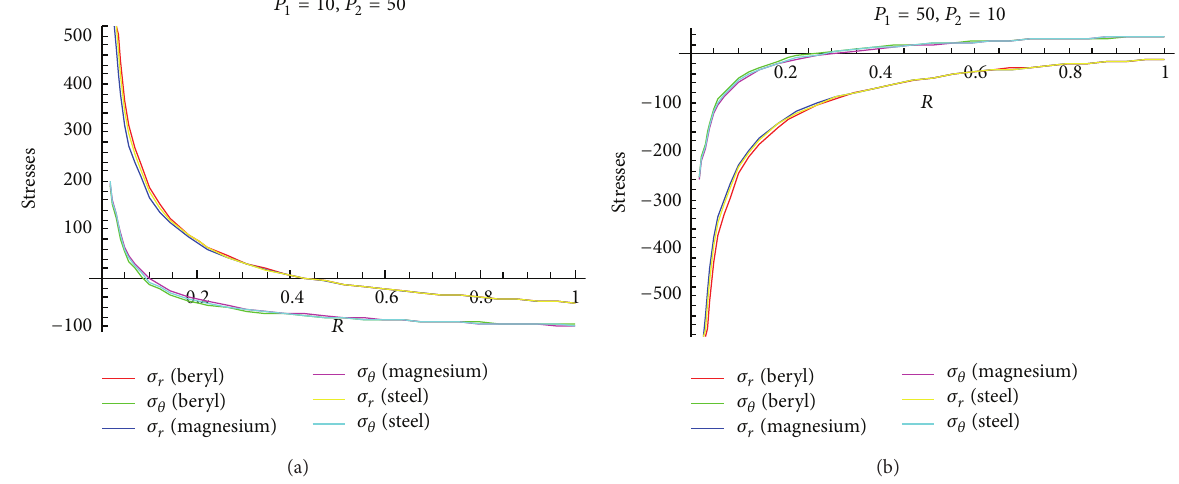
Figure 4: Transitional stresses when internal pressure = 10, external pressure = 50 and internal pressure = 50, external pressure = 10, respectively.